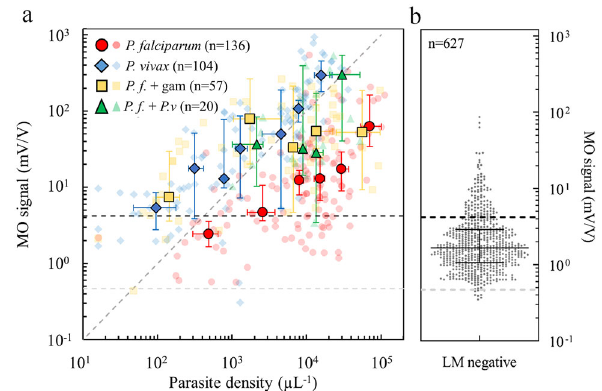
Fig. 3 Correlation of MO signals with parasite density as determined by expert LM. a MO signals as a function of parasite density for different species, as determined by expert LM. P. falciparum mono-infections without gametocytes are represented by red circles, P. vivax mono-infections by blue diamonds and P.f. + P.v . mixed infections by green triangles. Samples with gametocytes in P. falciparum mono-infections ( P.f . + gam.) are represented by orange squares. The larger, solid-colored symbols show median MO signals and median parasite densities for representative parasite density ranges, with 95% CIs as error bars. The smaller, transparent symbols show the individual test results. The number of biologically independent samples examined over three independent MO experiments is indicated in parentheses. The typical error of the MO signal for a given sample (measured in triplicates) is 11% (individual error bars are not indicated). The diagonal dashed line with a slope equal to 1 represents linear proportionality of the MO signal with parasite density. The dashed horizontal black line represents the cut-off value (MO = 4.19 mV/V) determined by the ROC analysis for all LM positive samples (see Table 2). The dashed horizontal gray line is the median MO background signal (0.47 mV/V) determined in malaria naïve volunteers, which provides a signi fi cantly lower cut-off value. b MO signals of patient samples with undetectable parasites by expert LM ( n = 627). Also indicated are the median, 1.67 (95% CI: 1.57 – 1.78), and the IQR (1.06 – 2.89) of the MO